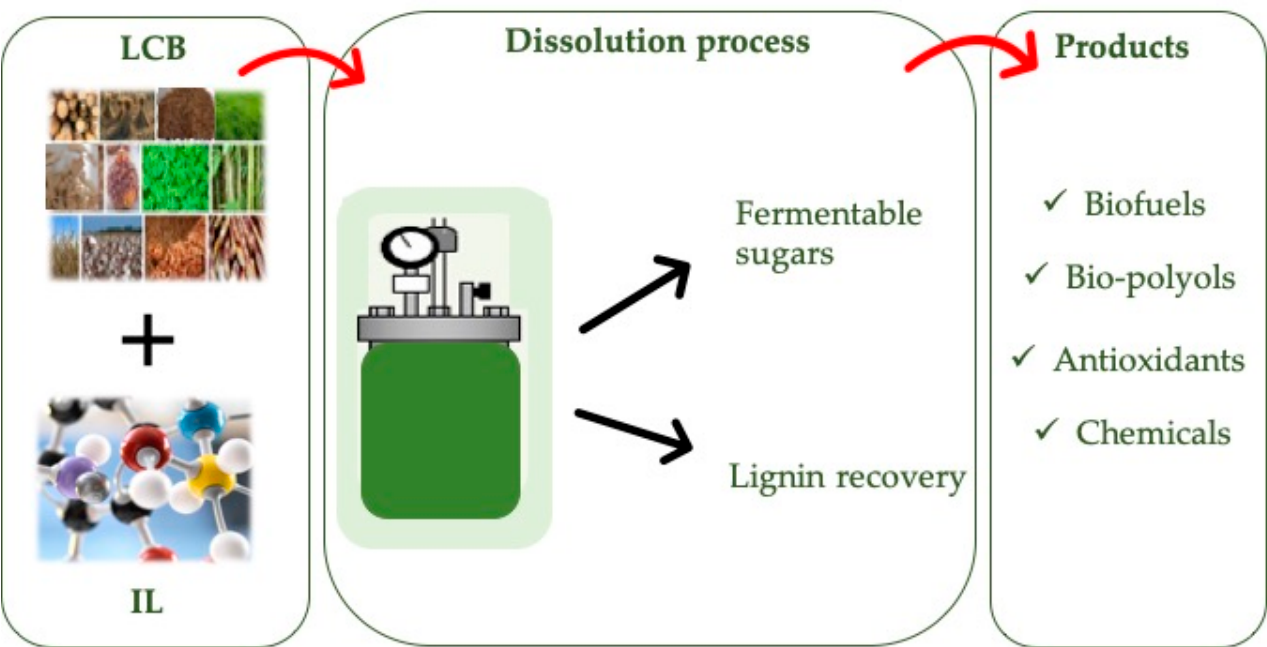
Figure 1. Application of ionic liquids (ILs) to the deconstruction and fractionation of lignocellulosic biomass (LCB).